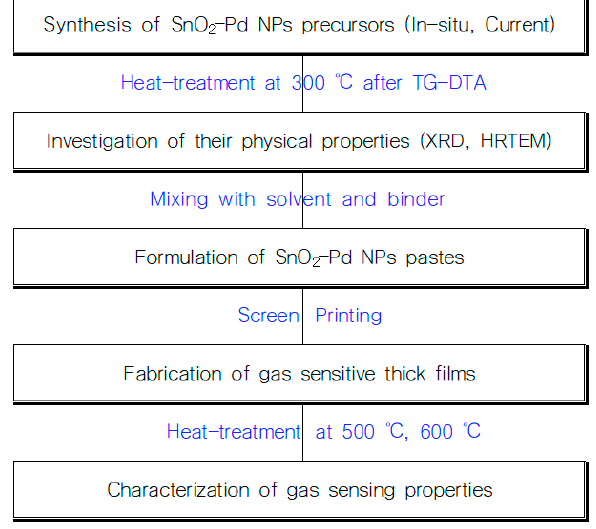
Figure 1. Example diagram of the gas sensors.